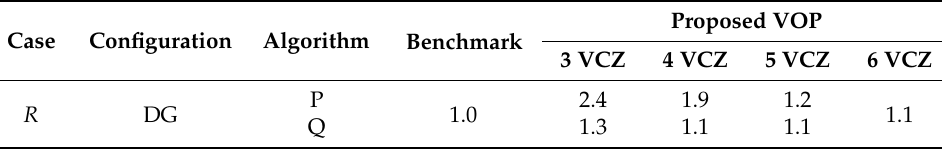
Table 8. Normalized objective functions (p.u.) for Case R — DG